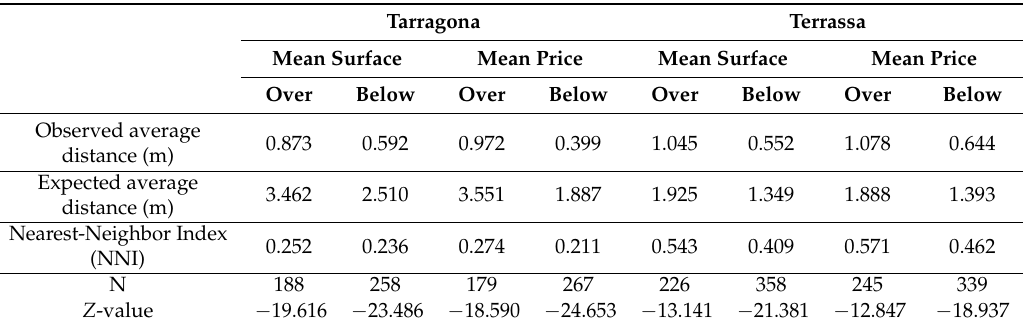
Table 6. Nearest-Neighbor Index (NNI) related to mean surface area and mean